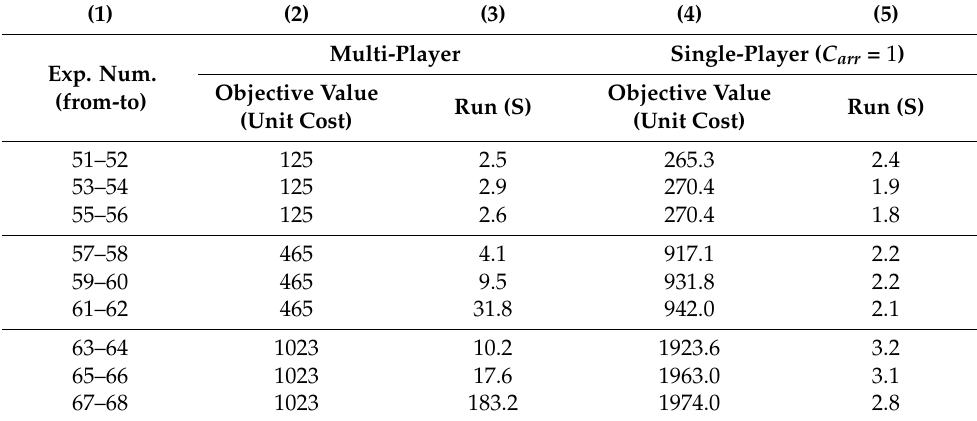
Table 7. Results of